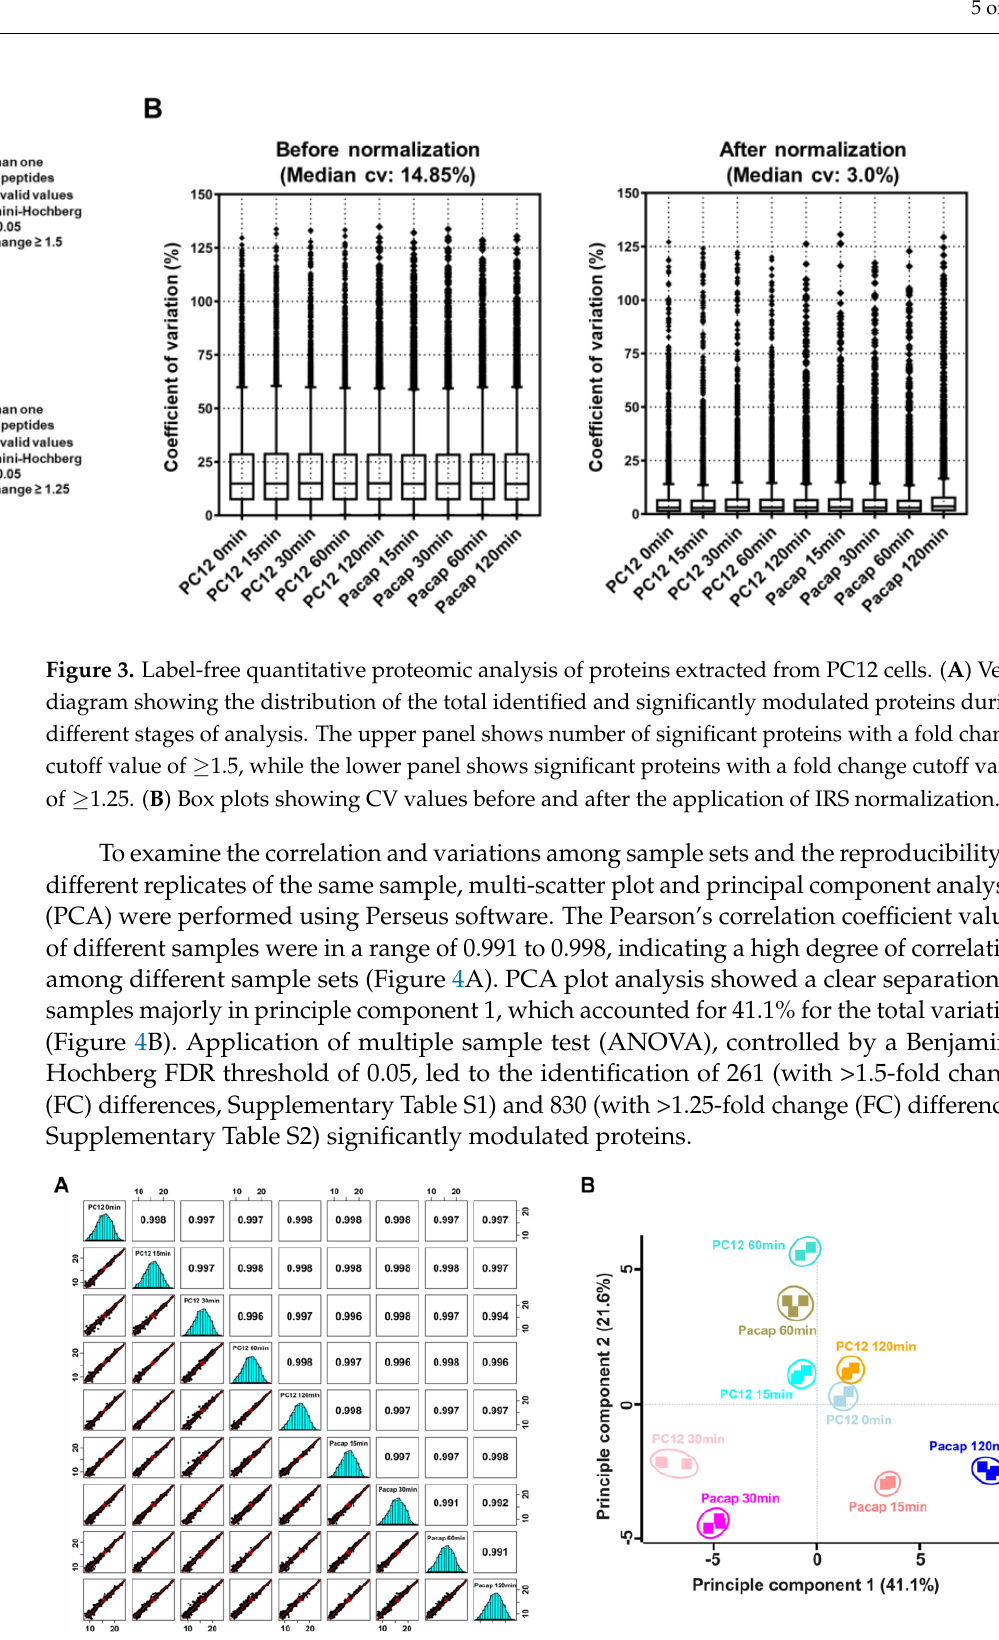
Figure 4. ( A ) Multi-scatter plot indicating the correlation between protein intensities among PC12 sample sets. Reproducibility across the replicate of three samples revealed by Pearson’s correlation value. ( B ) Principle component analysis of significantly modulated proteins identified by TMT-based quantitative proteome analysis.